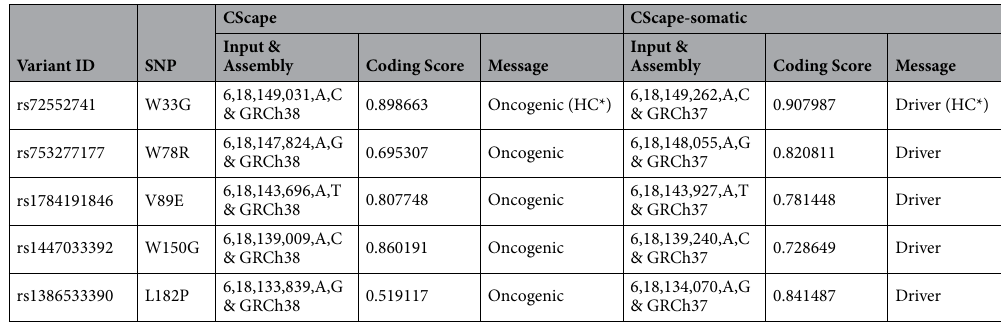
Table 4. : Oncogenic nature of mutations predicted using CScape and CScape-somatic. *HC = High